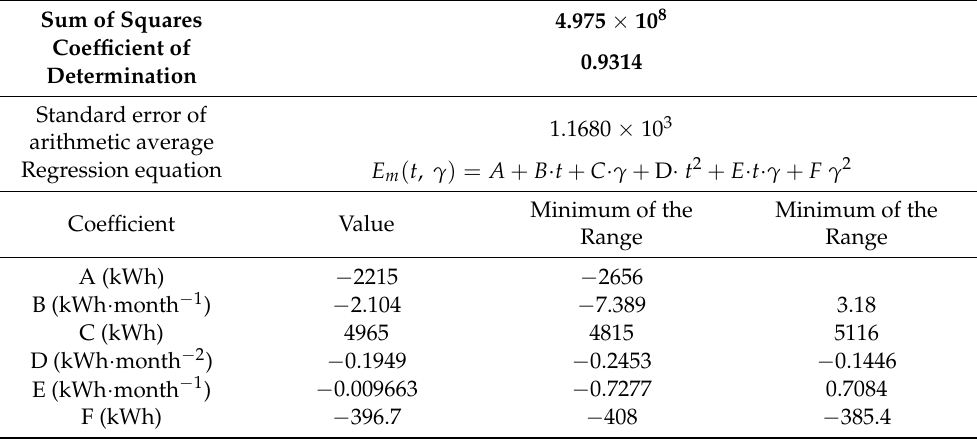
Table 3. The statistical and regression characteristics of approximated polynomial function for three-dimensional dependence in Figure